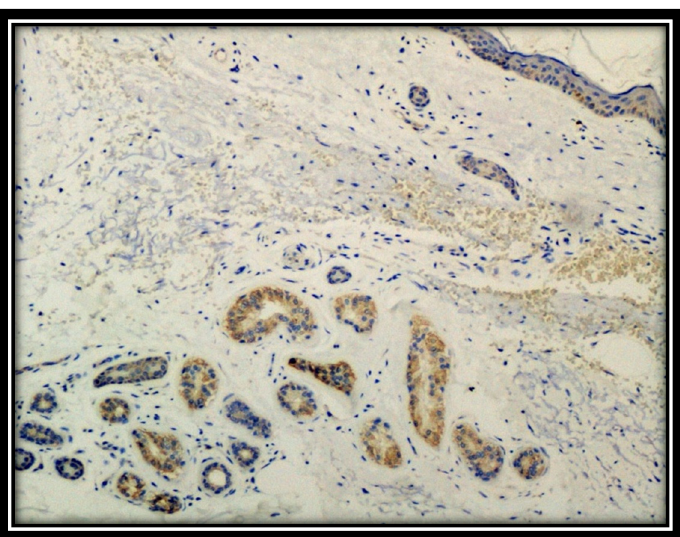
Figure 1. Immunostaining for S1 spike protein of SARS-CoV-2. Note the positivity at the level of eccrine sweat glands (Immunohistochemistry, Original Magnification: 10×). Table 1. Summary of the salient features of the immunomarkers used in this